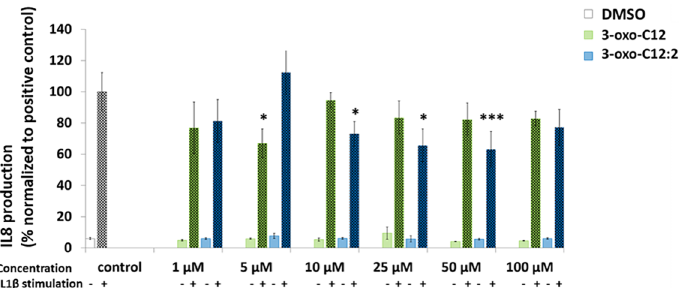
Fig 8. IL-8 (normalized ratio) secretion by Caco-2/TC7 cells before and after IL1 β stimulation with increasing concentrations of AHLs 3-oxo-C12 and 3-oxo-C12:2 compared to control (DMSO 0.1%). (cid:3) p < 0.05 (cid:3)(cid:3)(cid:3) p < 0.001.